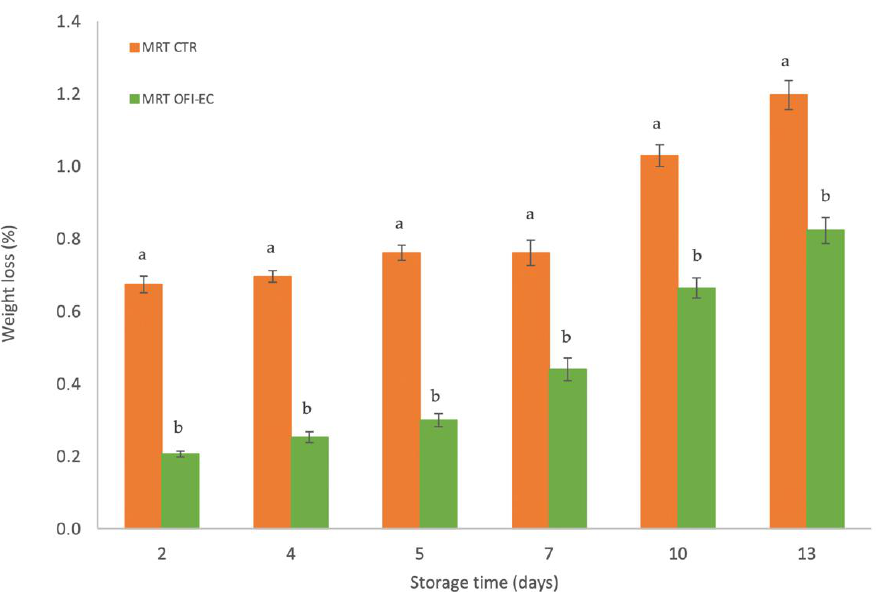
Figure 1. Changes in weight loss (%) in minimally processed Martorana loquat fruits, untreated fruit (MRT CTR), and fruits treated with mucilage (MRT OFI-EC) during cold storage (13 days at 5 °C). Different lowercase letters indicate significant differences at p ≤ 0.05 between the treatments on each sampling date. Data are the mean ± SE (Vertical bars represent standard error; n = 5).